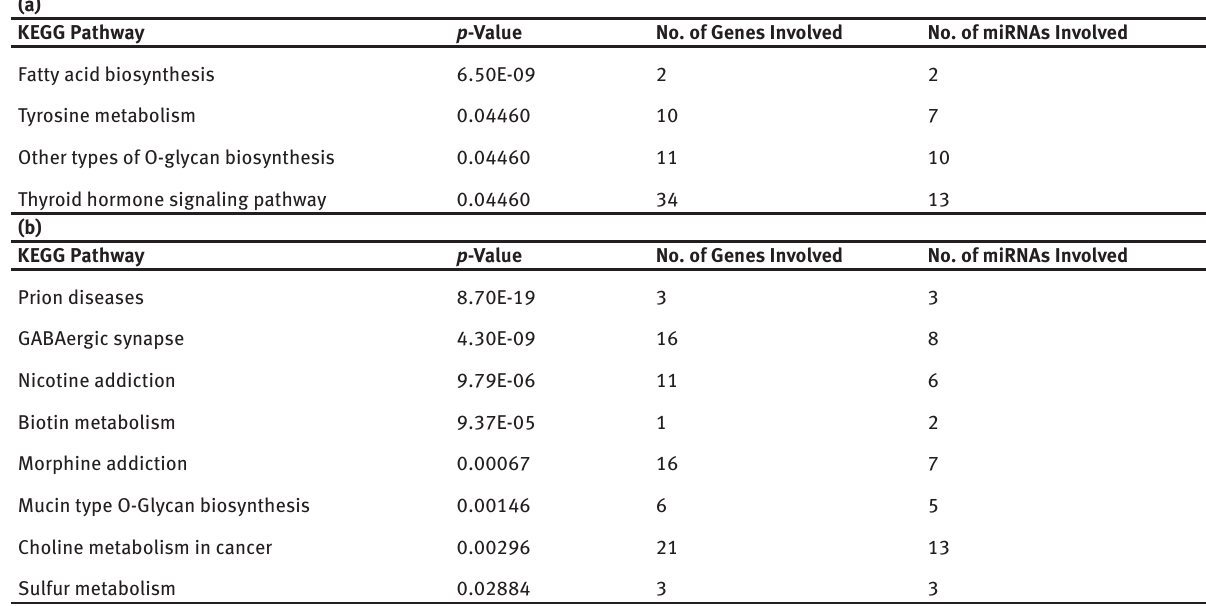
Table 3: KEGG annotation of cellular pathways potentially affected by downregulated miRNAs (a) and upregulated miRNAs (b) due to SDF-1 treatment in human